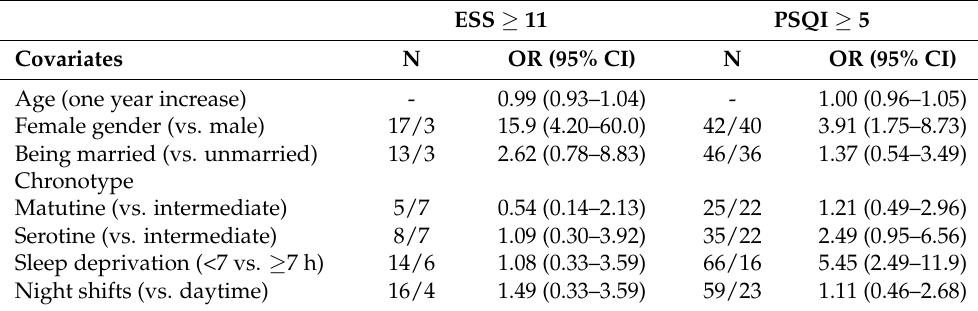
Table 3. Results of the logistic regression model predicting an ESS score ≥ 11 and a PSQI score ≥ 6. ESS ≥